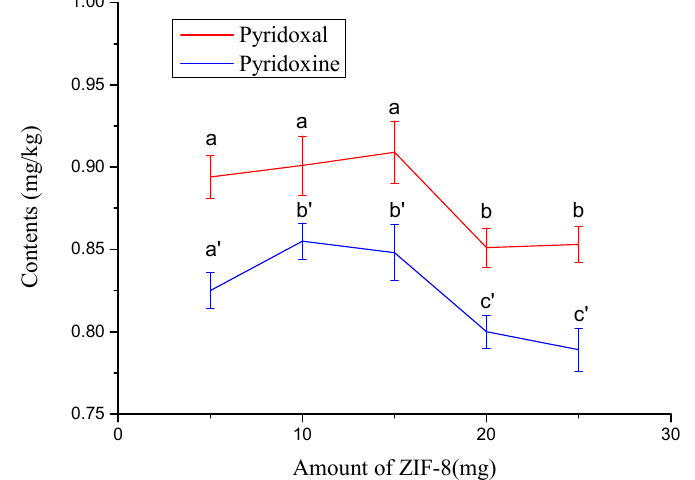
Figure 7. Effects of amount of ZIF-8 on measured contents of pyridoxal and pyridoxine. The values not sharing a common letter (a, b) or (a’, b’ and c’) are significantly different ( p ≤ 0.05).